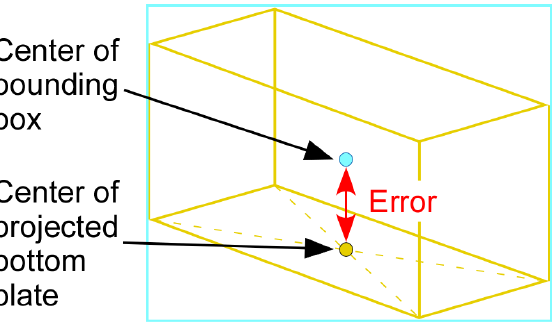
Figure 4 . Camera view of a vehicle in the spherical coordinate system .